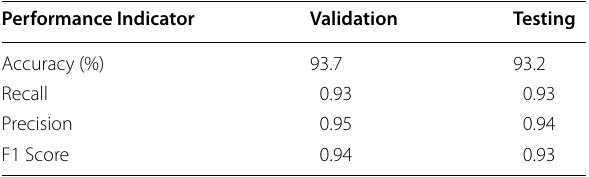
Table 1 Performance indicators